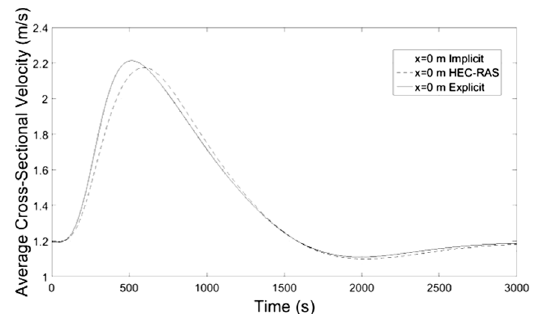
Figure 10. Flow Depth-Time at x = 0 m.